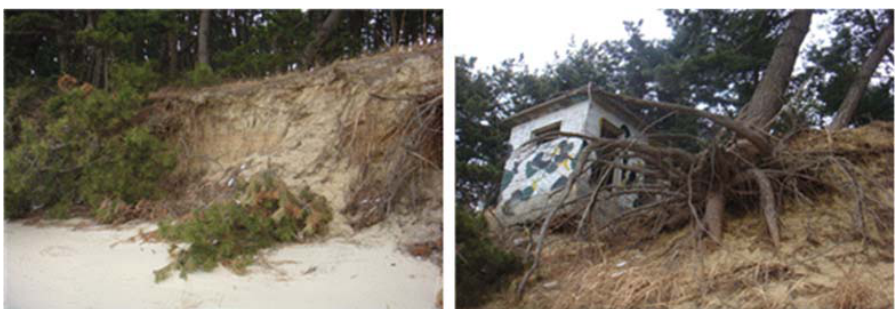
Figure 1. Location of Janghang Songrim Beach in Geum Estuary, Republic of Korea.